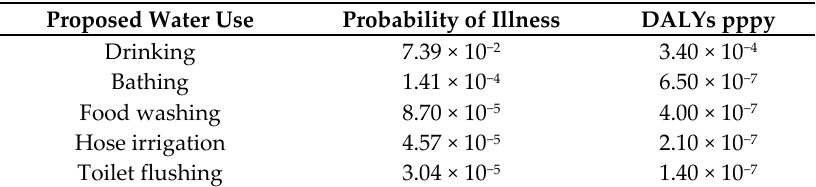
Table 3. Median values of annual risk for different RHRW